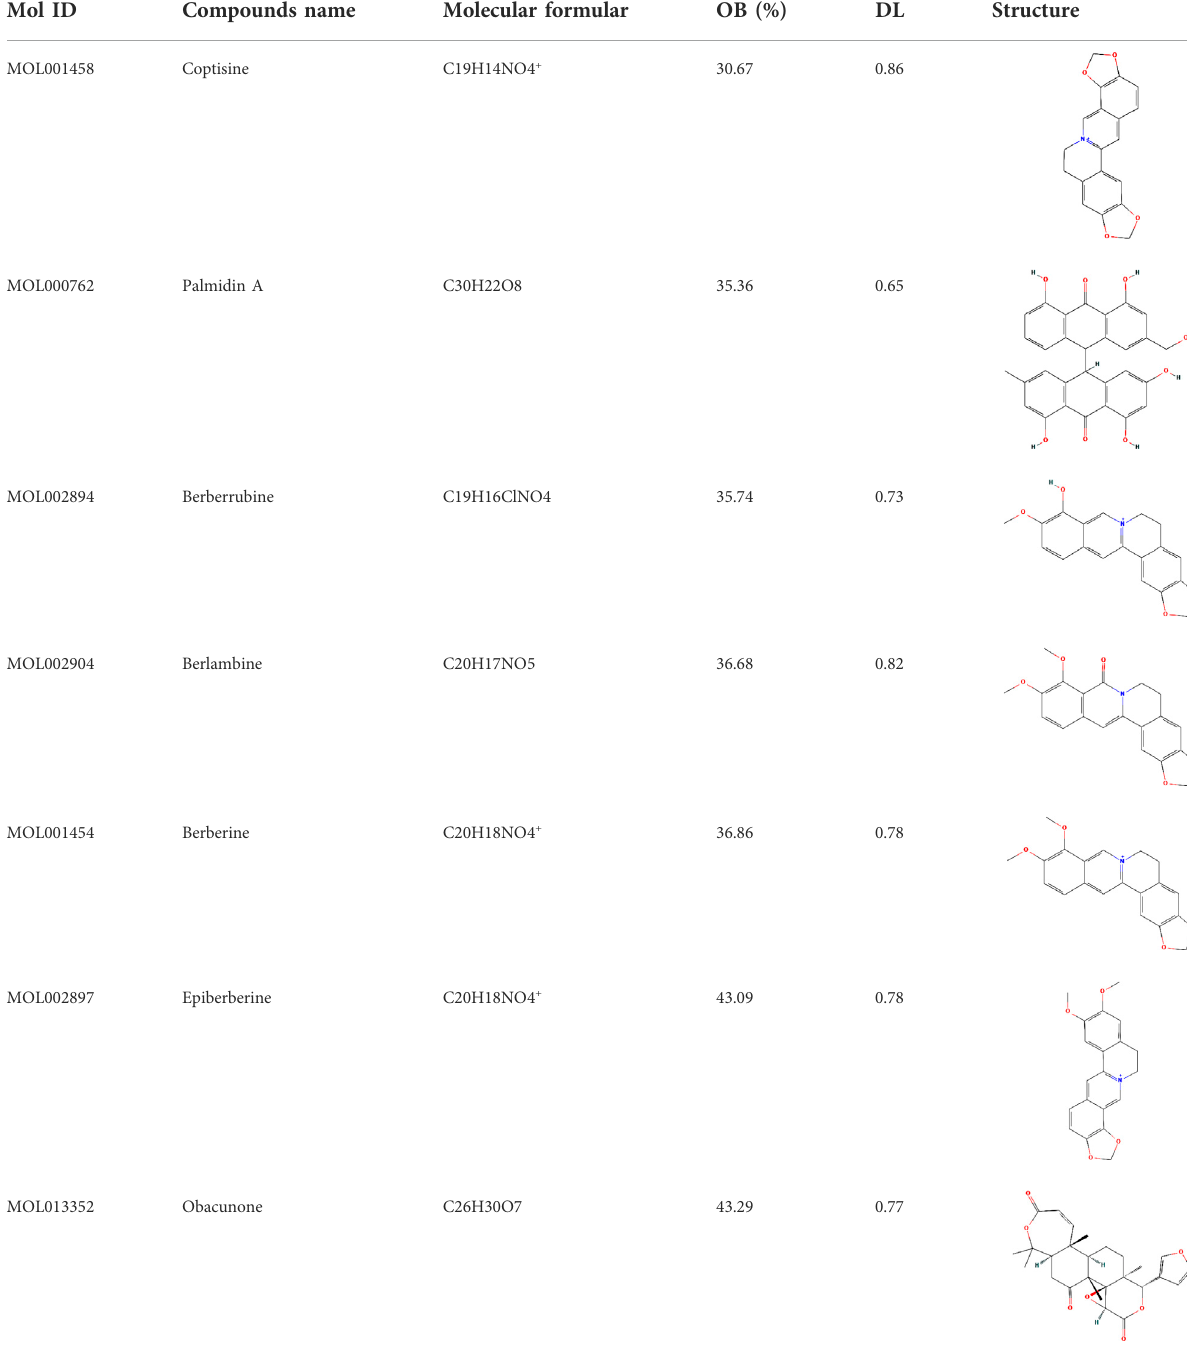
TABLE 1 Basic information of key phytochemicals of